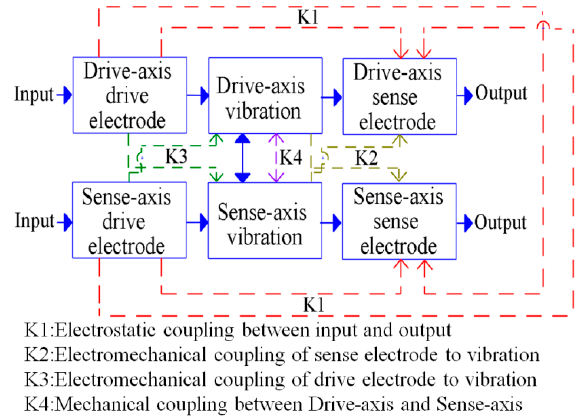
Figure 1. Classification of unnecessary coupling of a dual-axis control input, dual-axis position sensing gyroscope.